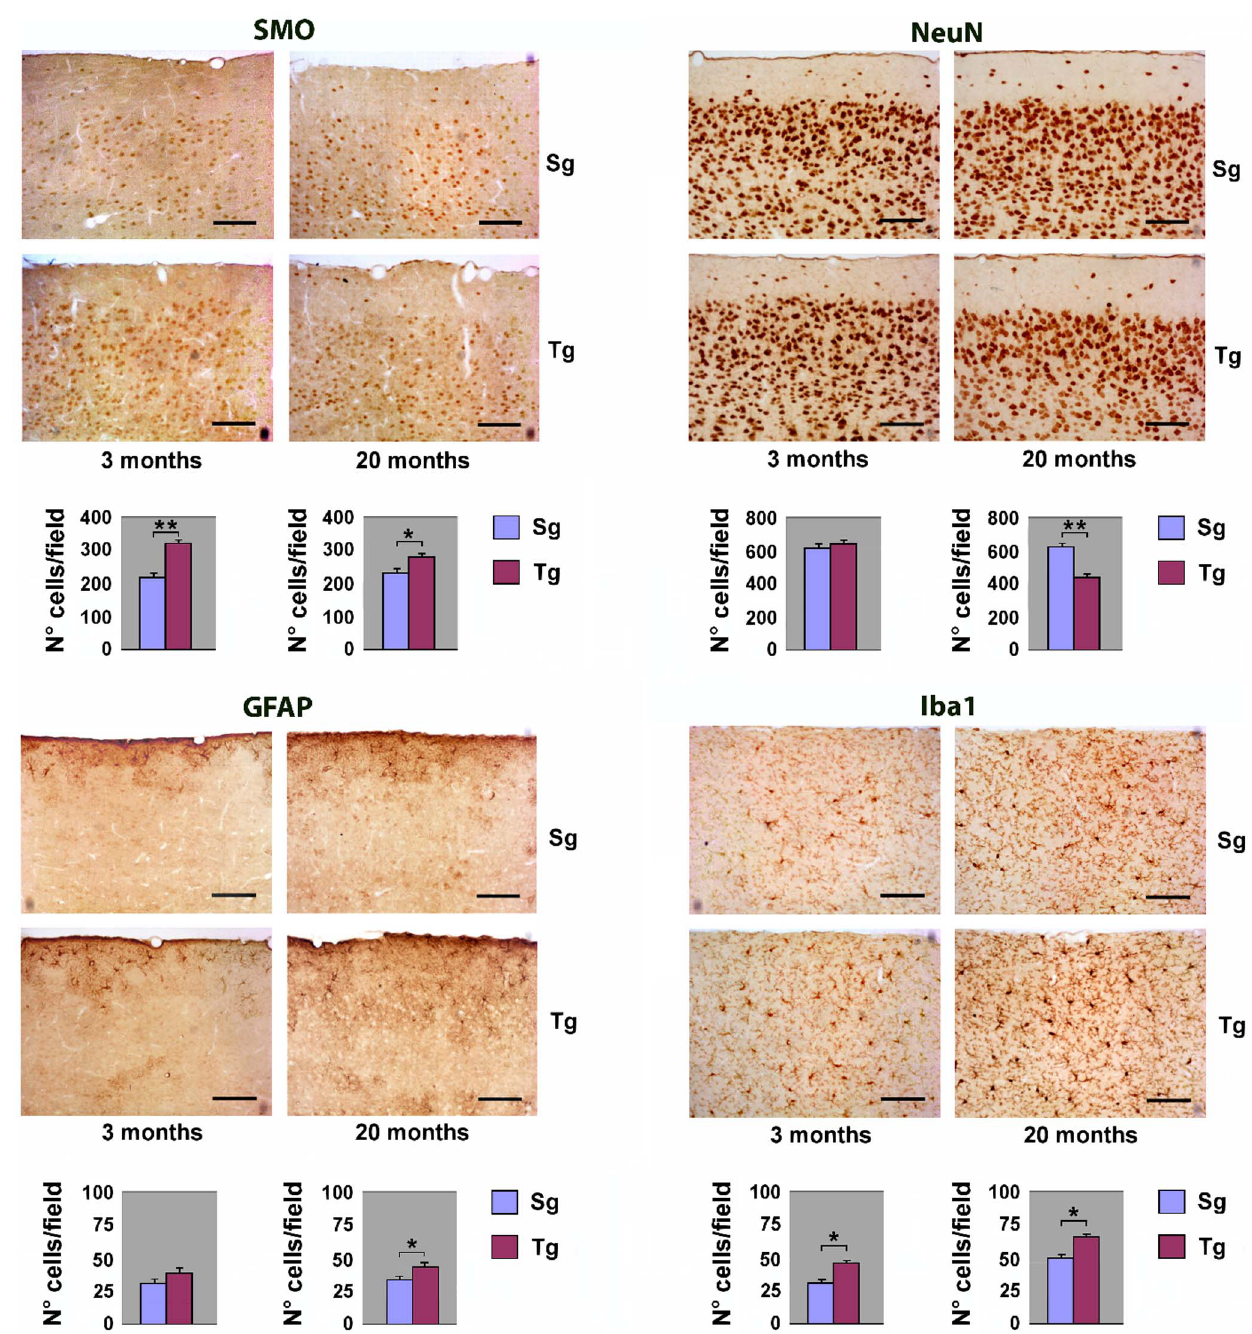
Figure 3. Immunohystochemical analysis of neocortex from Tg and Sg mice. Sagittal brain slices from JoSMOrec mice were stained with antibodies directed against SMO, NeuN, GFAP and Iba1. Slides of neocortex from 3 and 20 months old mice were analyzed. Cell counting is expressed as number of positive cells per 0.24 mm 2 area. The p values were measured with the one-way ANOVA test and post-hoc test Bonferroni (*, p , 0.05; **, p , 0.01; ***, p , 0.001). Sg, syngenic mice; Tg, transgenic mice. level in Tg mice. KA treatment resulted in a significant increase by observed between Tg and Sg mice at 3 days (Figure 8A). While no 200% of the SSAT activity at 1 day and remained significantly difference was observed in APAO basal activity between Tg and higher at 3 days in the Tg mice respect to Sg mice (Figure 8A). Sg neocortices, 1 day after injury this enzyme showed a strong ODC activity measured at 1 and 3 days after KA injury, was increase in both genotypes, especially dramatic in the Tg apparently unaffected in either Tg or Sg mice (Figure 8A). neocortex (300%). Furthermore, three days after KA injection, APAO activity decreased in both Tg and Sg samples, down to the basal level in Sg mice, but still higher by two folds than the basal